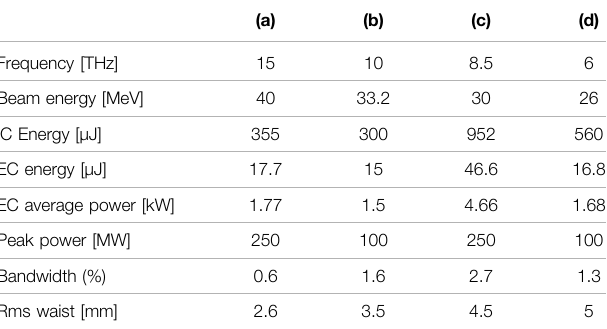
TABLE 5 | Properties of the intra-cavity (IC) and extra-cavity (EC) radiation at different frequencies for TerRa@BriXSinO, assuming beam peak current of